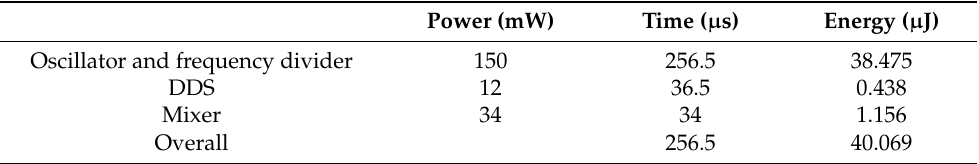
Figure 13. Power consumption of frequency mixer as a function of the supply voltage. Table 1. Power consumption of bioimpedance